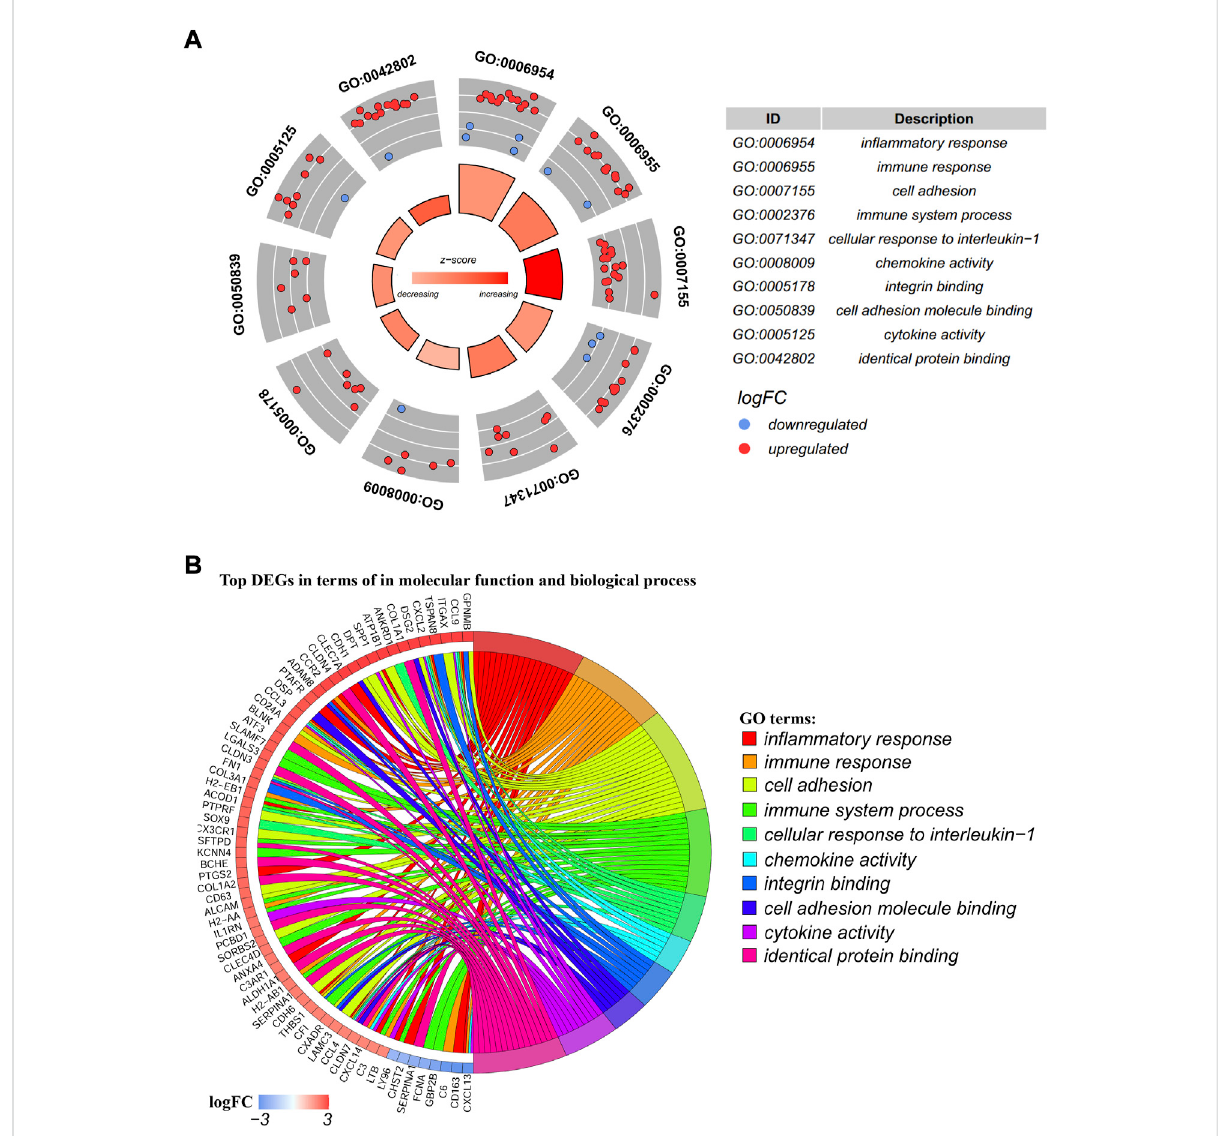
FIGURE 3 GO(GeneOntology)termsenrichmentanalysis. (A) GOcircleplot;theinnerringwasabarplotwherethebarheightshowedthesigni fi canceof the term ( − log10 p -value) and the gradual color showed the z-score. The outer ring displayed scatter plots of the expression levels (logFC) for the genes in each term. The distribution of genes in different GO terms was used to predict different annotations. (B) GO chord plot of the relationship between the list of selected genes and their corresponding GO terms, together with the logFC of the genes. The left half of the GO chord displayed the up-expression or down-expression DEGs. The right half represented different GO terms with varied colors. A gene was linked to a certain GO term by the colored